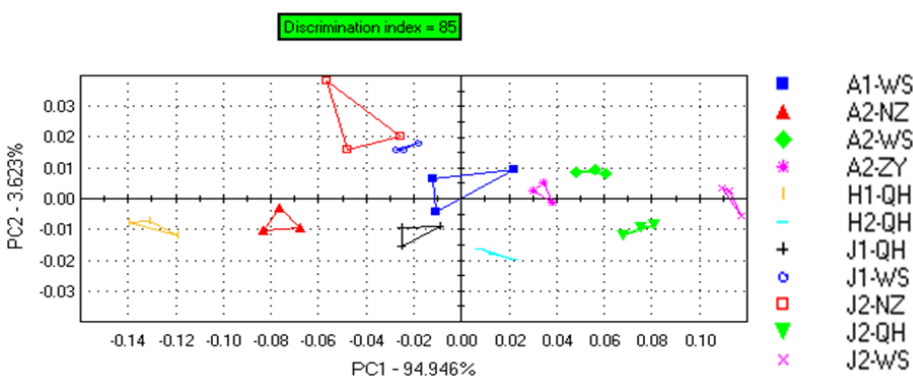
Figure 1. PCA plot for the E-nose results for each of the eleven groups of puffer fish.